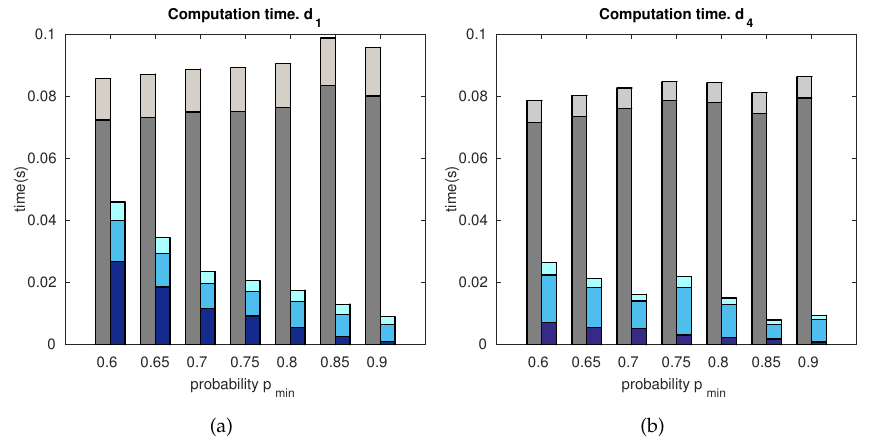
Figure 13. Computation time versus p min . ( a ) Distance d 1 ; ( b ) distance d 4 . Legend: (cid:4) standard matching: matching computation; (cid:4) standard matching: localization computation; (cid:4) proposed matching: candidates’ computation; (cid:4) proposed matching: matching computation; (cid:4) proposed matching: localization